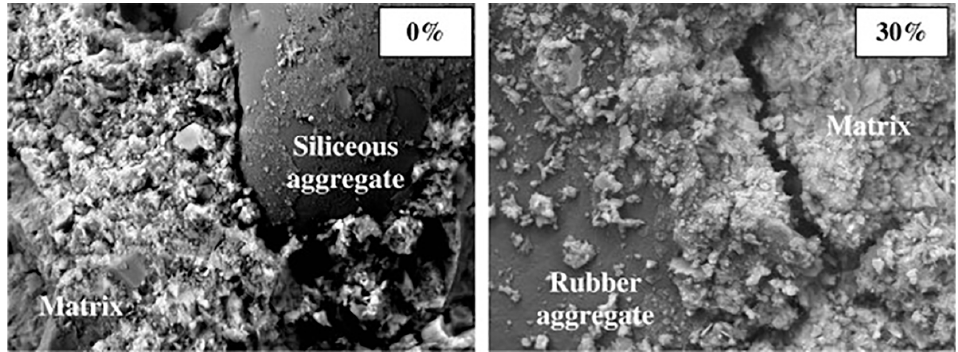
Figure 2. Adherence of ITZ of mortars with 0% RA and RA mortars with 30% RA [55].